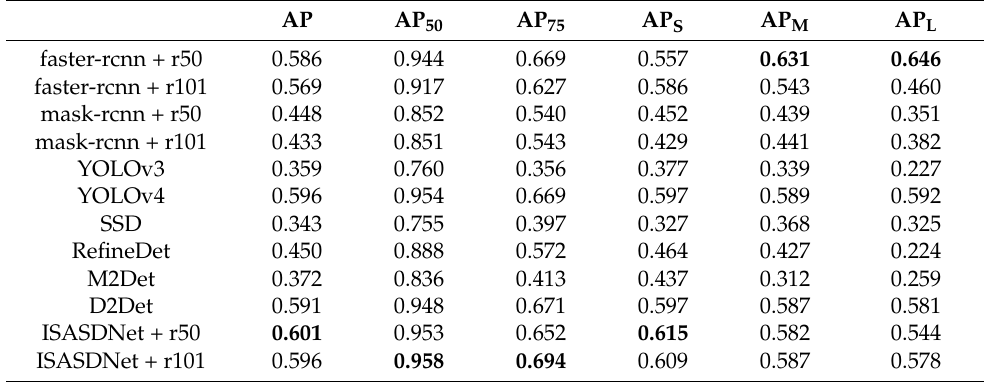
Table 2. AP of different methods on SAR-Ship-Dataset.